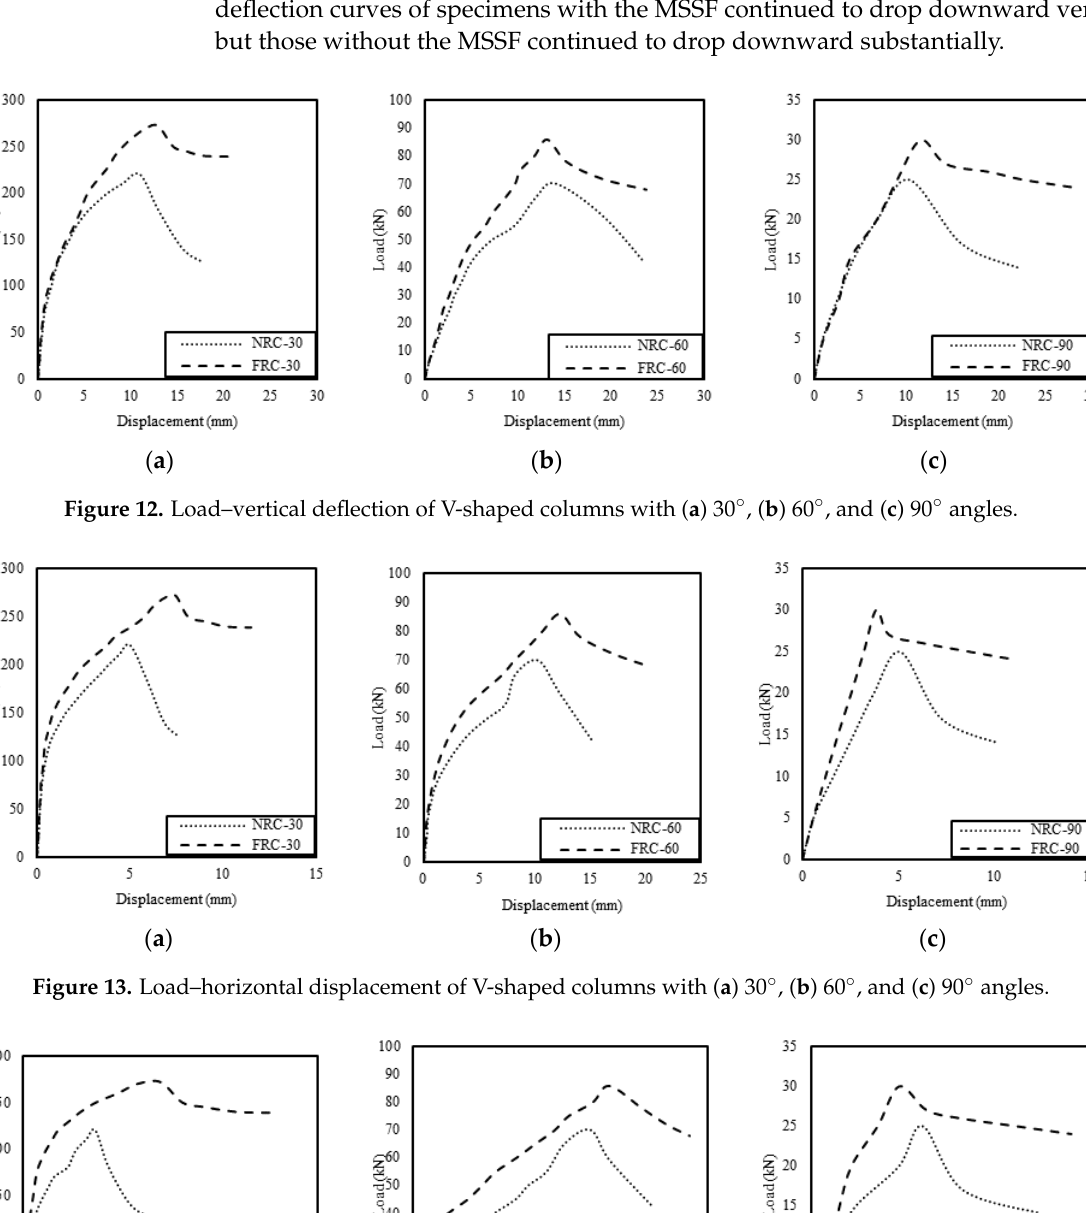
30 3.2.2. Load – Displacement Behavior The experimental load – vertical deflection, load – horizontal displacement, and load – relative displacement diagrams of the V-shaped columns with the NSC and SFRC are pre- sented in Figures 12 – 14, respectively. In these figures, the ultimate load capacities of the V-shaped columns were substantially affected by the angle of inclination and inclusion of MSSF. The diagrams showed that the addition of MSSF into concrete enhances the ulti- mate load and ductility of the V-shaped columns. The improvement in the V-shaped col- umn ultimate load resulting from the inclusion of MSSF was greater than the vertical col- umns tested under concentric load. With the inclusion of MSSFs in the V-shaped columns, the ultimate load capacity was increased by 24, 23, and 20% for V-shaped columns with 30, 60, and 90° angles of inclination, respectively. The axial load capacity of column FRC- 30 was 32% higher than the load capacity of column NRC-30. The compressive failure strength of the NSC column was 19% lower than the SFRC column. This improvement is due to the fiber-bridging effect on the post-cracking compressive strength of the SFRC column.